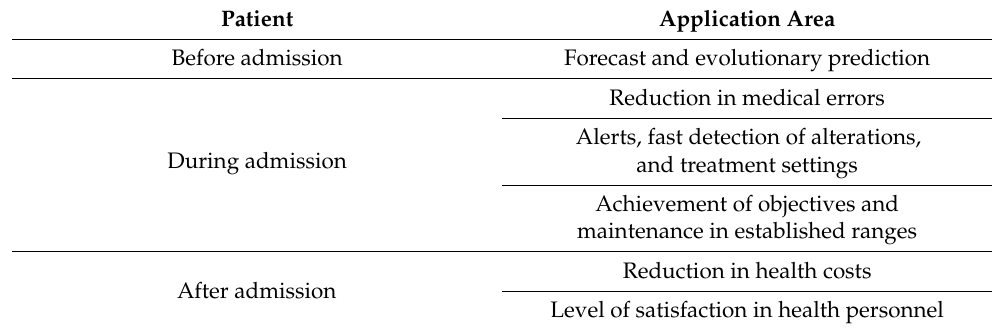
Table 2. Summary of the results field of the